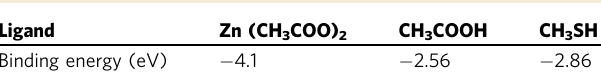
Table 1 Binding energy of different ligands on (100) ZnSe surface.